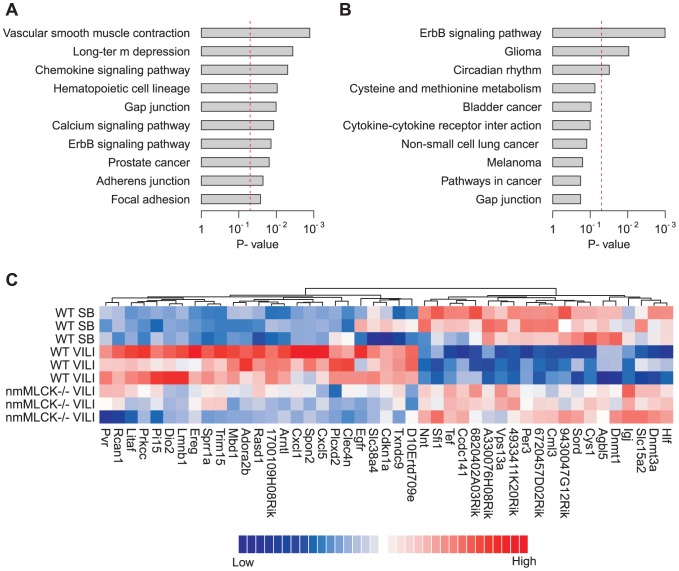
nmMLCK-mediated mouse genes.(A) Enriched pathways among the differentially expressed genes between WT VILI-exposed and VILI-exposed nmMLCK KO mice. The red line indicates the cutoff of significance (P<0.05). (B) Enriched pathways among the 45 nmMLCK-mediated genes. The red line indicates the cutoff of significance (P<0.05). (C) Heatmap of expression for WT control, WT VILI-exposed, and VILI-exposed nmMLCK KO mice. Red represents increased gene expression; Blue represents down-regulation.